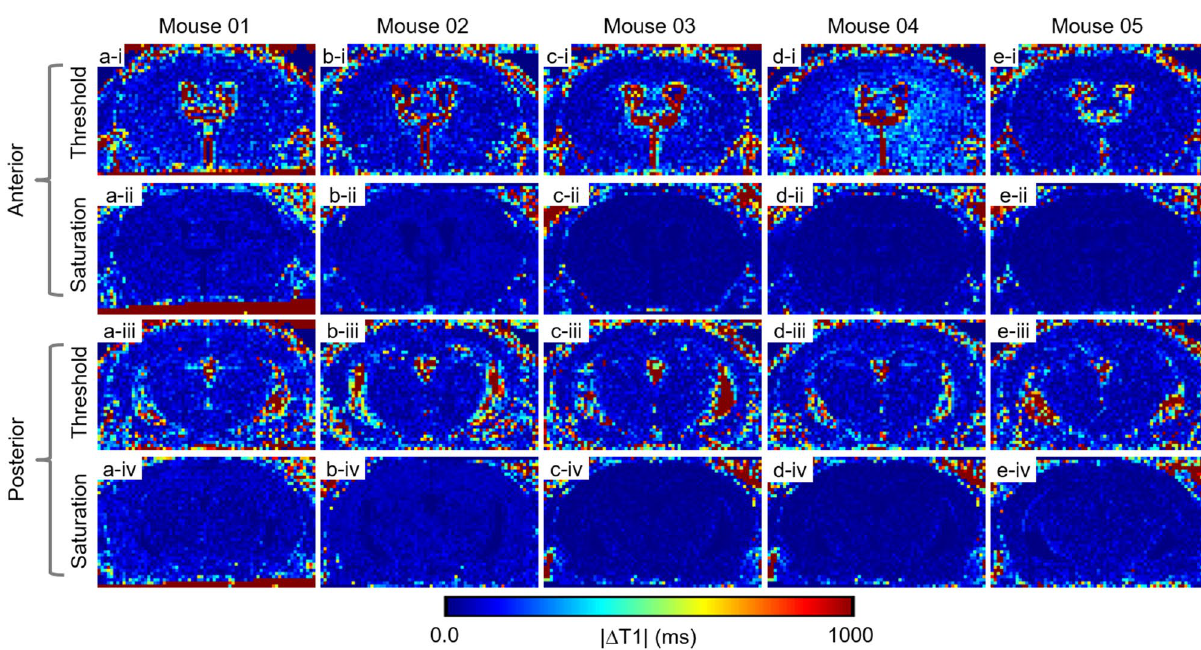
Figure 4. Absolute ΔT1 between first scan and second scan in 5 control mice. ( a – e ) Each column represents an individual mouse. Rows i, iii: absolute ΔT1 after co-registration using the threshold method. Rows ii, iv: absolute ΔT1 after co-registration using the saturation method. In all 5 mice, the saturation-based approach produced more accurate co-registration result than the threshold-based